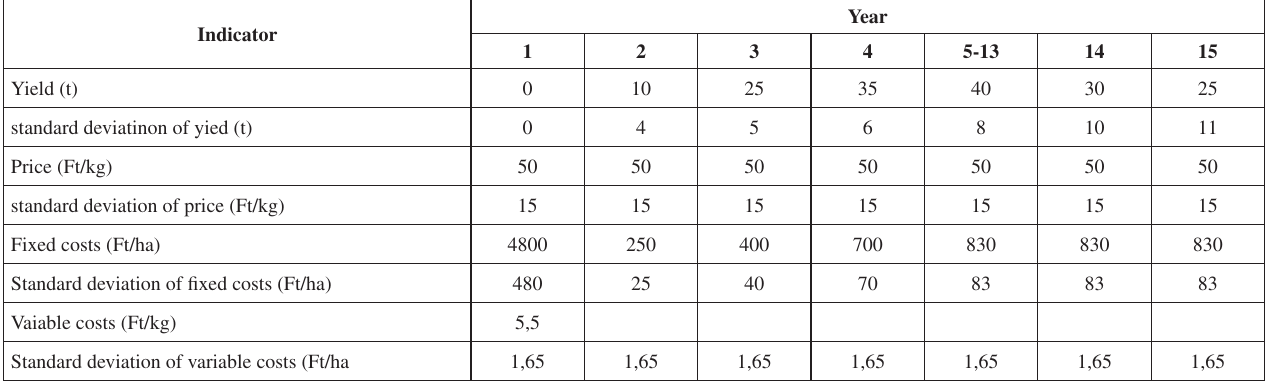
Table 2. Base data of the apple-production model without cold